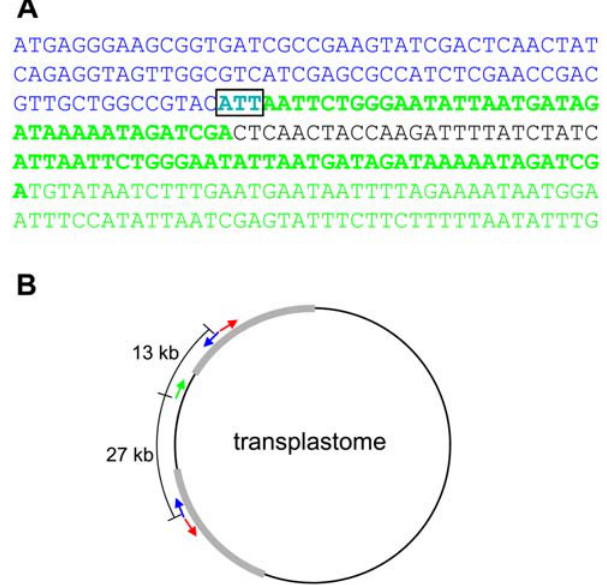
Figure 5. Origin and partial sequence of the kr2.5 nuclear integrant. A. Partial sequence of the kr2.5 nuclear integrant. Blue text indicates aadA sequence, beginning from the start codon, and green text indicates plastid sequence, with the two bold regions being identical. The box highlights a 3 bp region of overlap between aadA and plastid sequences. Black text indicates non-plastid sequence of unknown origin. B. Structure of the transplastome showing the origin of kr2.5 nuclear integrant sequences (not to scale). Neo and aadA are represented by red and blue arrows respectively. They are present in two copies as they are located within the inverted repeats (shown in grey). The green arrow indicates plastid sequence adjacent to aadA in the kr2.5 nuclear integrant. In each case, the direction of the arrow corresponds to the direction of the sequence as written in part A.